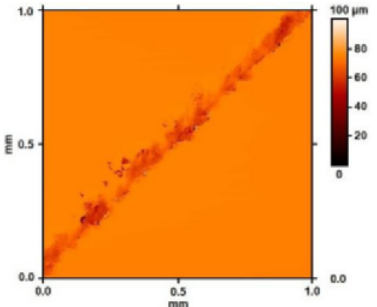
Fig. 1. Detail of a scratch on a mechanically polished surface .